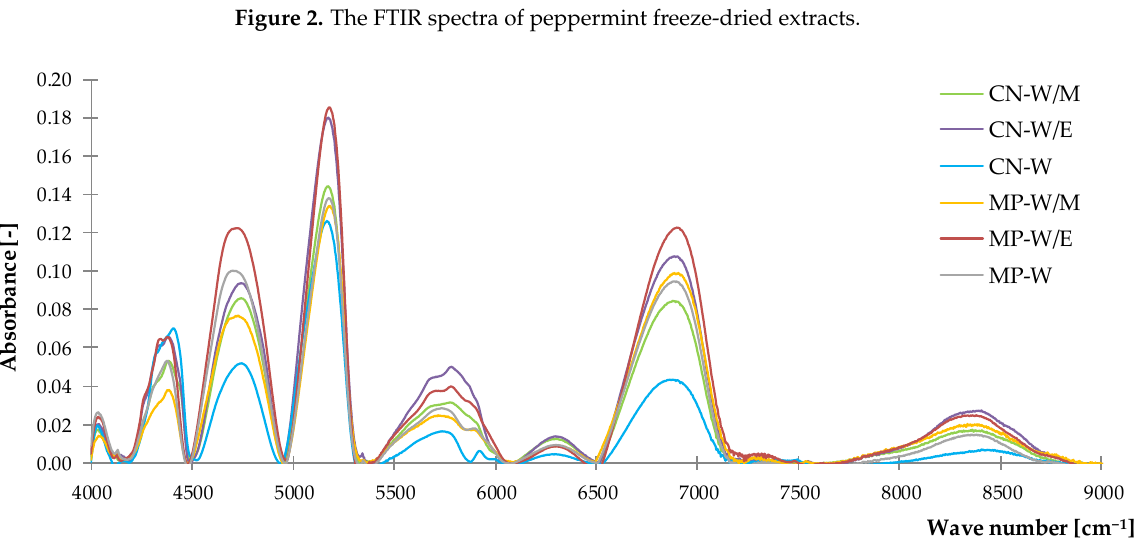
Figure 3. The NIR spectra of freeze-dried extracts. Table 3. Characteristic functional groups registered by NIR analysis. Adapted from refs. [81,87–89]. Peak Assignments and Type of